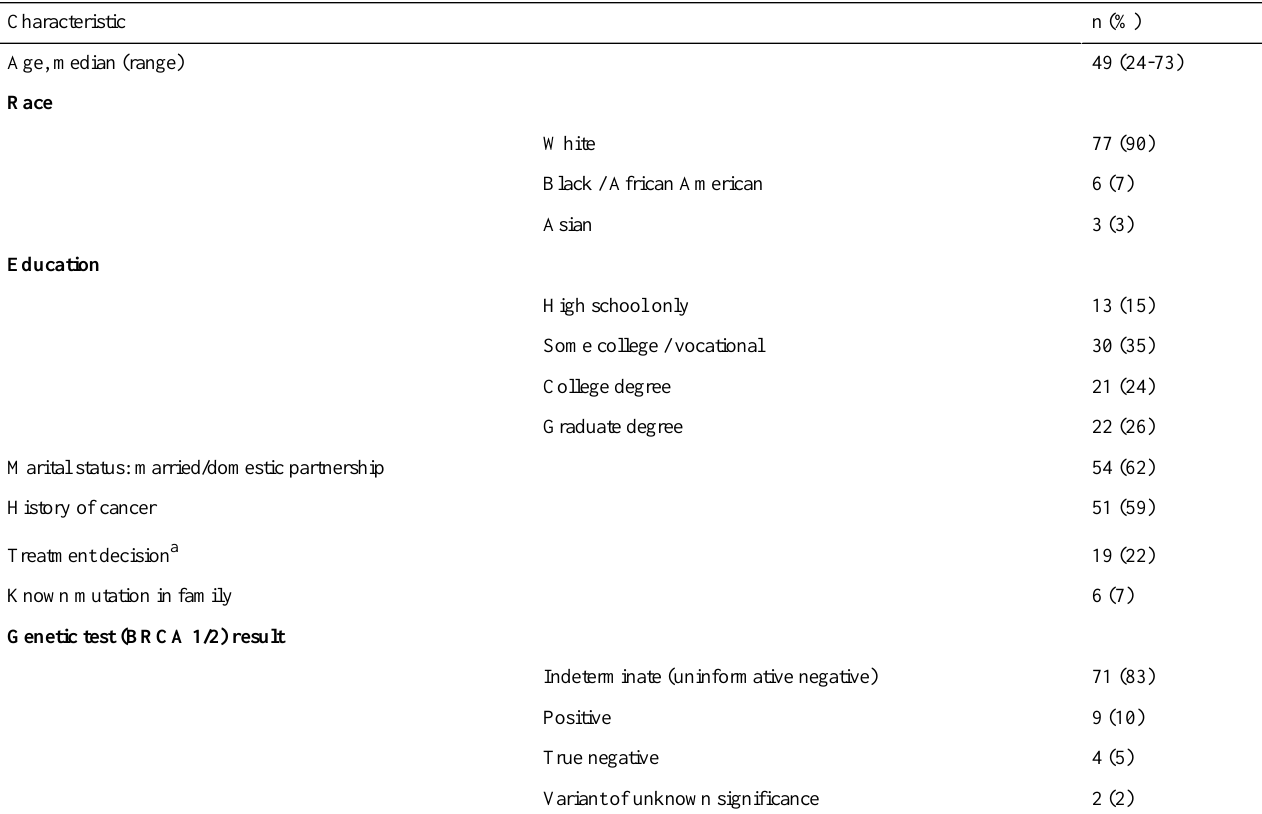
Table 2. Participant characteristics (participants who completed both pre and post disclosure assessments)